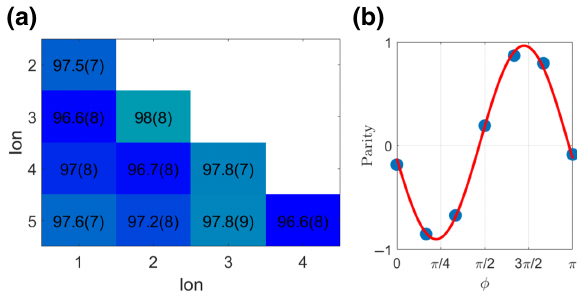
FIG. 5. (a) Fidelities for generating a two-qubit maximally entangled state by applying an entangling gate for every pair of qubits on a five-ion chain. The values are SPAM corrected, with an average fidelity of 0.973(2). The entangling gate is a cardioid (1,3) Mølmer-Sørensen, applied with an echo pulse mid- way through the gate. (b) An example parity measurement on a pair of qubits in the